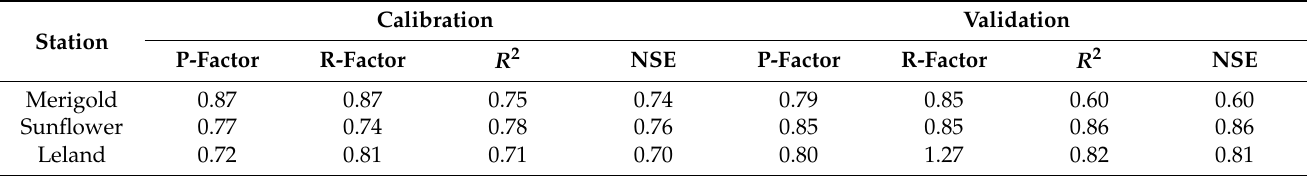
Table 4. Evaluation of model performance during streamflow calibration and validation.